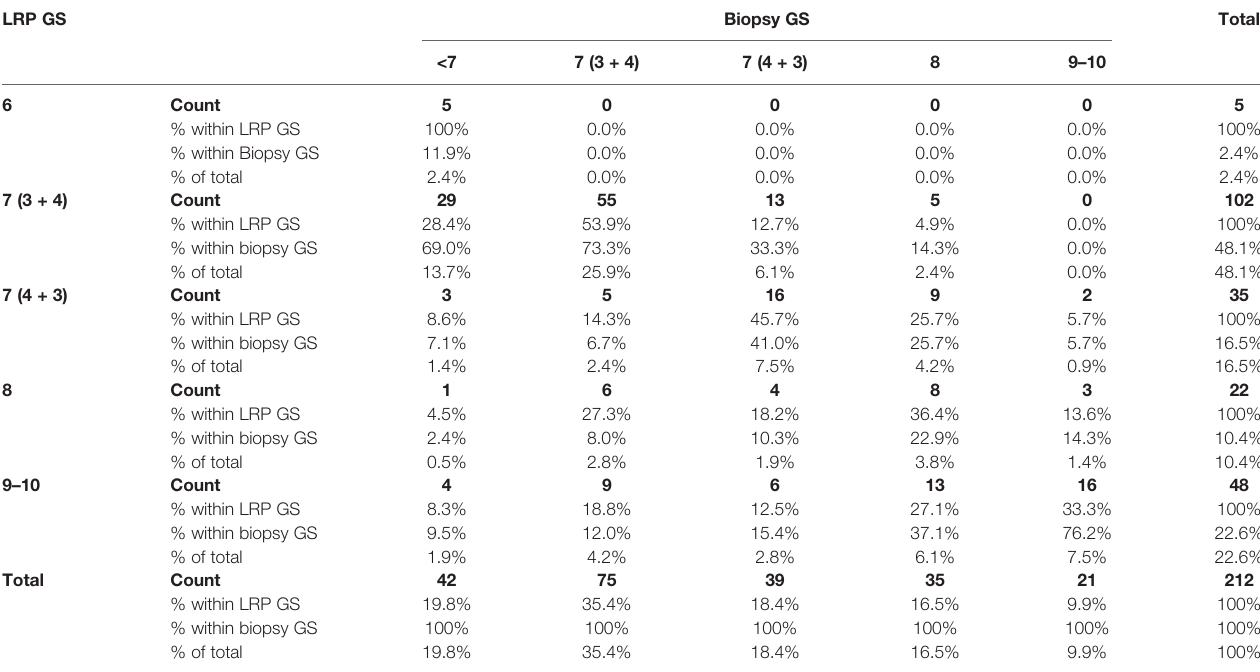
TABLE 2 | Radical prostatectomy grades strati fi ed by biopsy Gleason Scores.